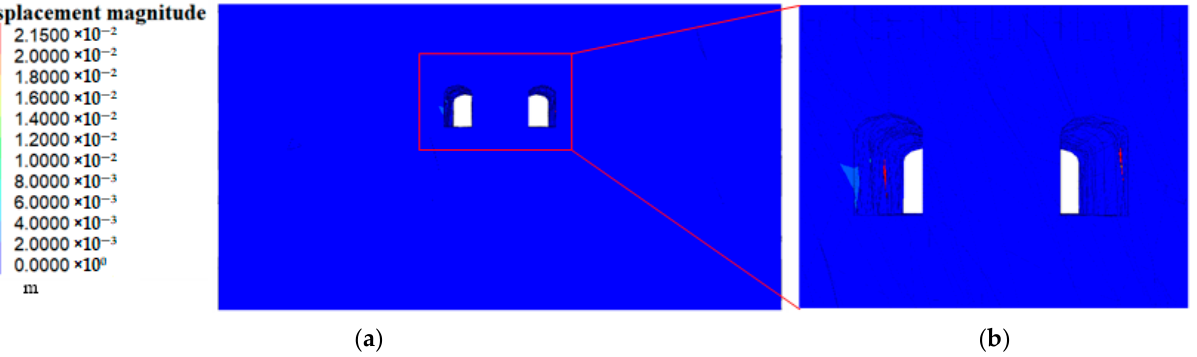
Figure 20. Displacement contours of surrounding rock of cavern: ( a ) Displacement of the study area, ( b ) Magnified displacement of surrounding rock (7 MPa).